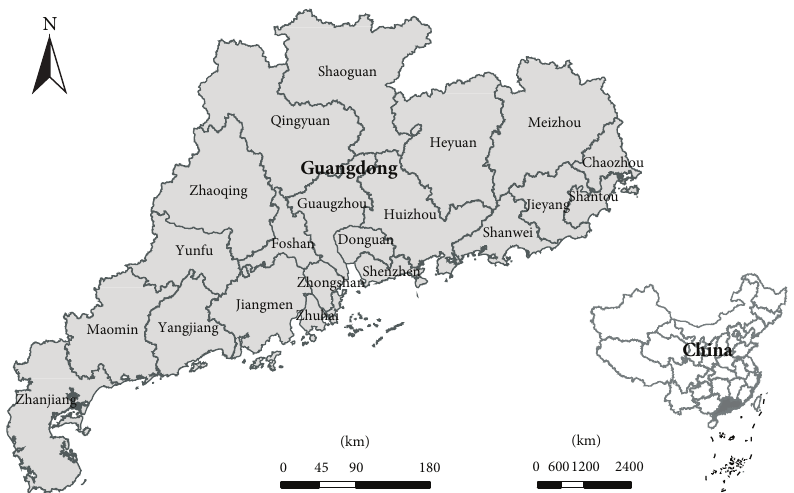
Figure 1: Geographic location and component cities of Guangdong Province in